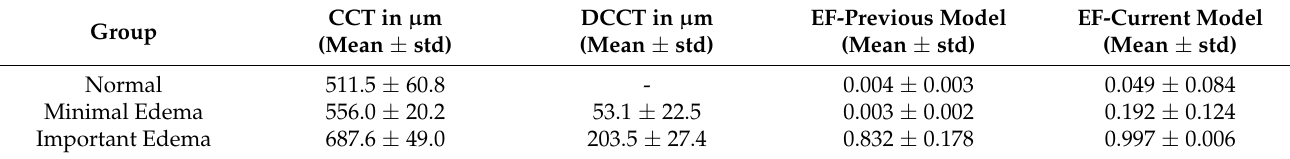
Table 1. Patients’ characteristics and main results. CCT: central corneal thickness; DCCT: differential CCT; EF: edema